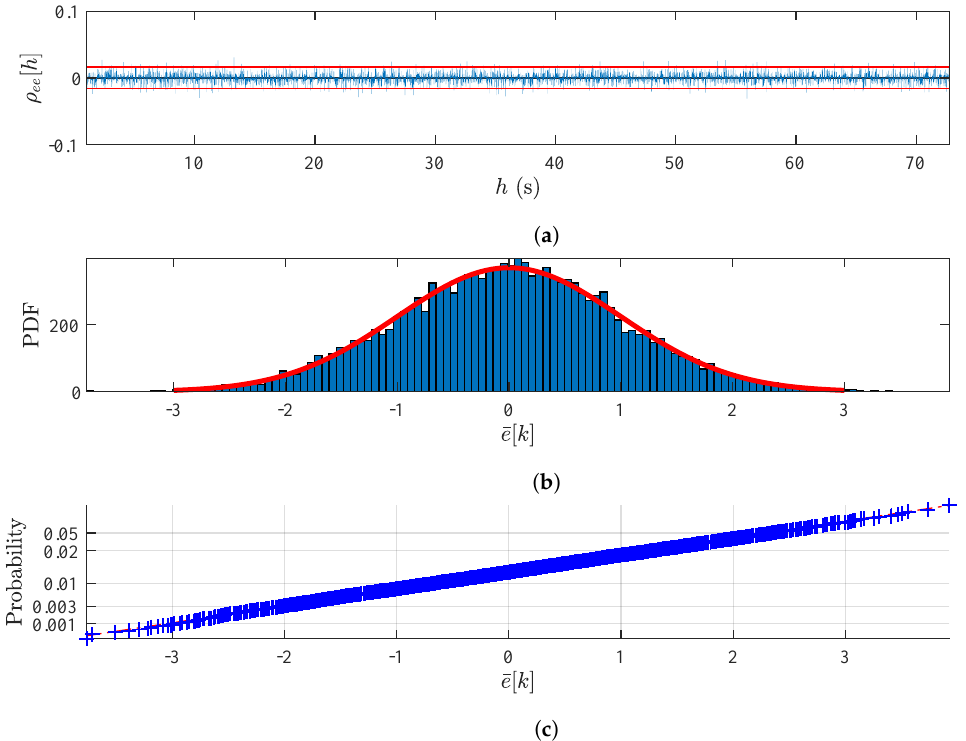
Figure 9. Spring-mass-damper: performance of the ARX 3 ( 38,38 ) prediction errors: ( a ) Sample autocorrelation function. ( b ) Sample PDF of the normalized ( e [ k ] ∈ N ( 0,1 ) ) prediction errors. ( c ) Normal probability plot of e [ k ] . Table 1. Spring-mass-damper: statistics of percentage fitness to the short time estimation data set during ARX